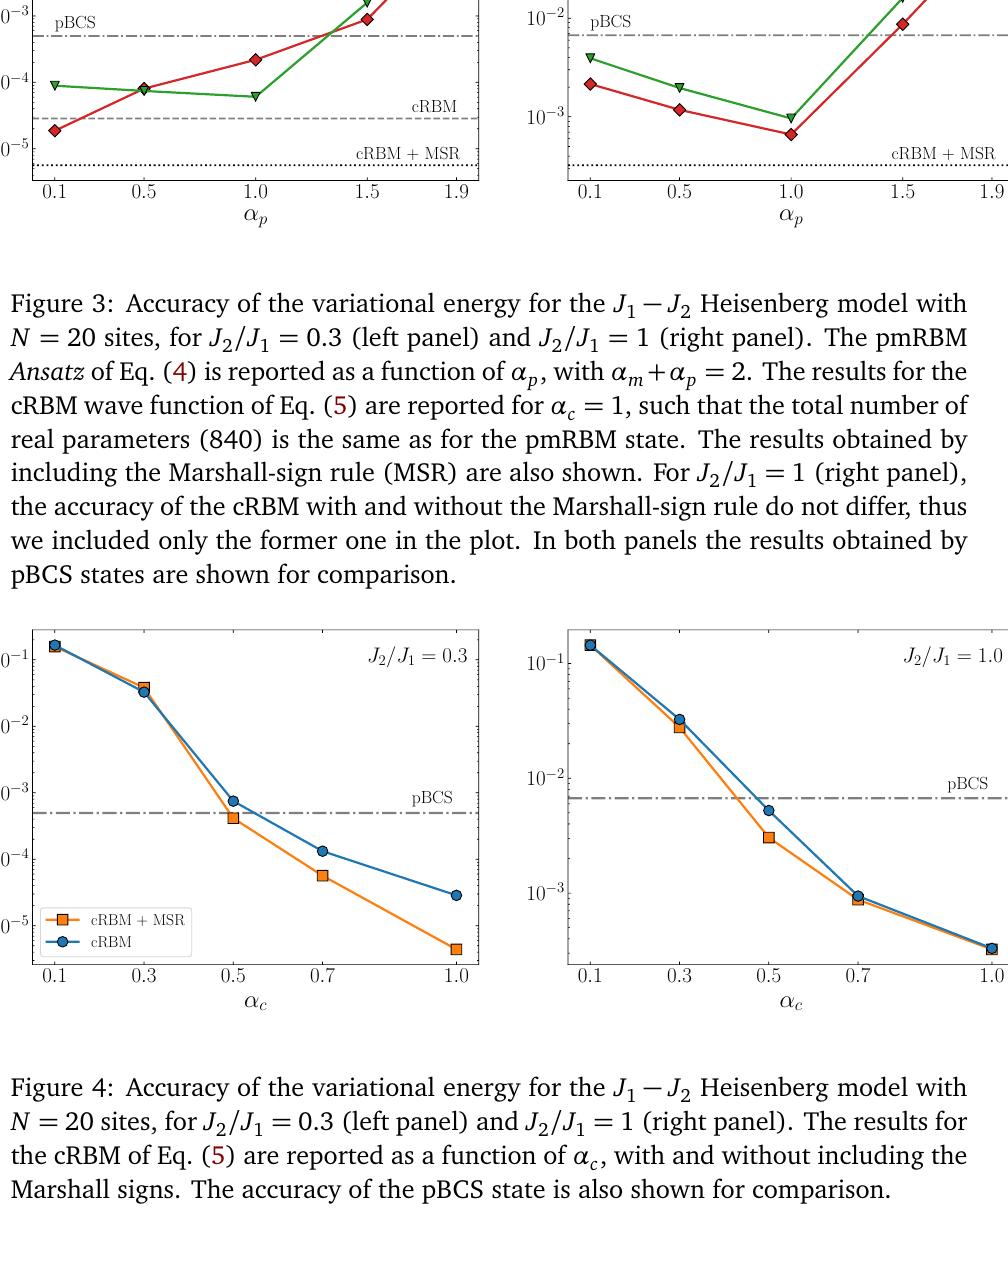
Figure 4: Accuracy of the variational energy for the J / J = 0.3 (left panel) and J N = 20 sites, for J 2 1 the cRBM of Eq. (5) are reported as a function of α Marshall signs. The accuracy of the pBCS state is also shown for